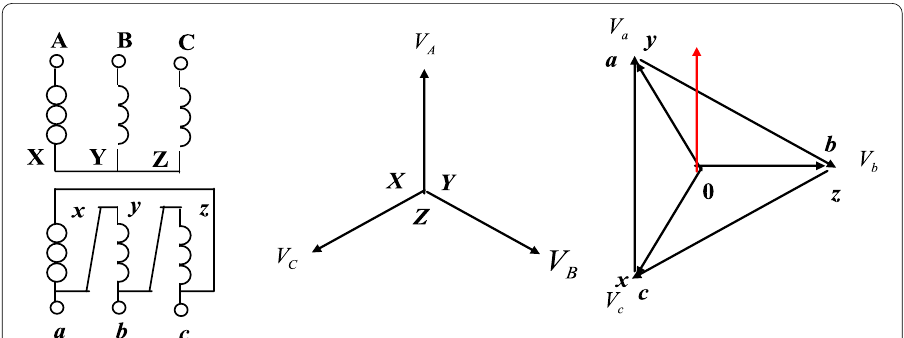
Fig. 4 YN, d11 connection of the transformer; In the left side, YN, d11 connection of the transformer is showed.In the middle, it shows the vector relationship between voltage and terminal in the Y side. And the right side of the figure it shows the vector relationship between voltage and terminal in the D side of the